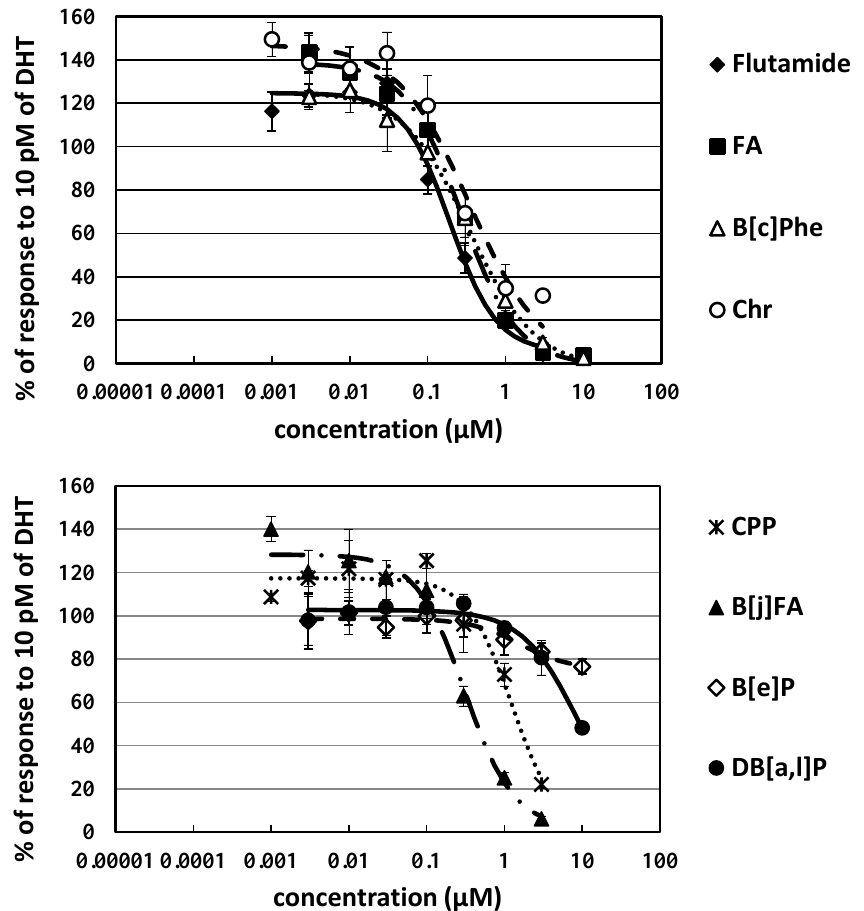
Figure 4. Dose–response curves of antiandrogenic activities for PAHs in 24 h exposure experiments with the AR-CALUX assay.